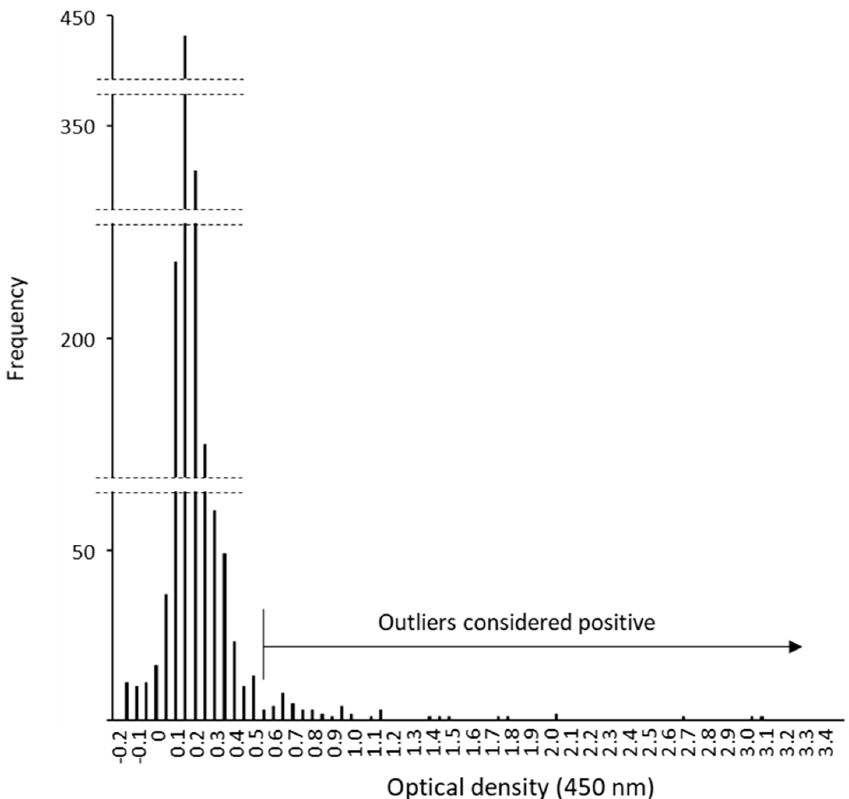
Figure 2. The frequency distribution of the NHP serum samples according to OD values obtained by GP-based ELISA. Serum samples were tested (1:1000 dilution) for IgG antibodies specific to EBOV, SUDV, TAFV, BDBV, RESTV, and MARV GPs. All OD values (6 virus species for 243 samples, n = 1458) were subjected to the Smirnov–Grubbs rejection test to discriminate the positive (i.e., significantly higher outlier values) from the negative population. The frequency distribution chart reveals that the sample population consists of a major single peak with low OD values (approximately < 0.5) and outliers ( p < 0.05) with high OD values (approximately > 0.55).